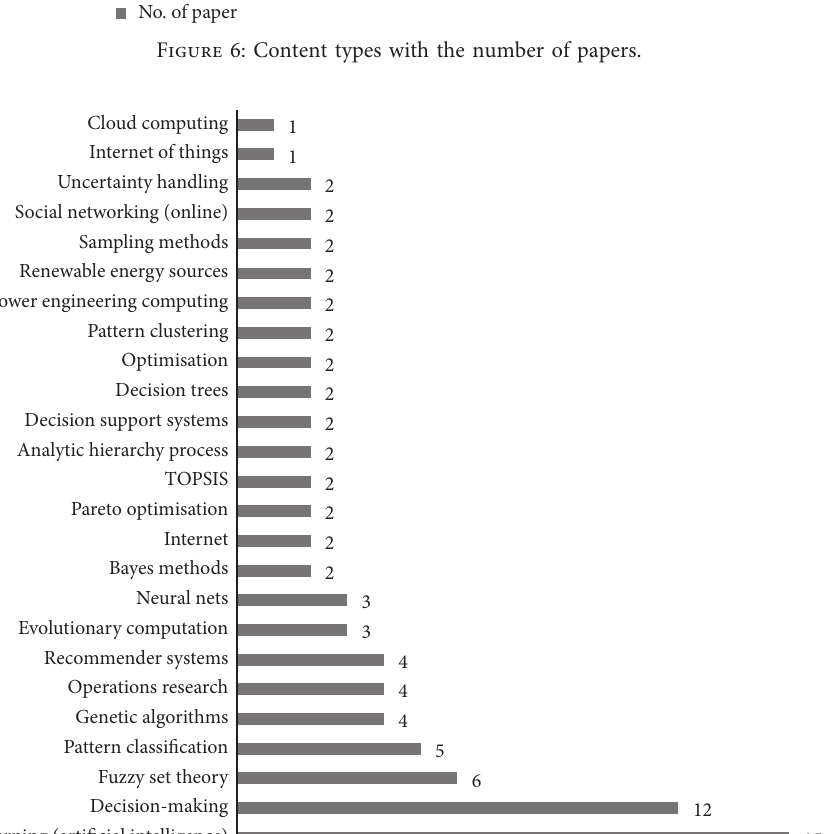
Figure 7: Publication topics with the number of